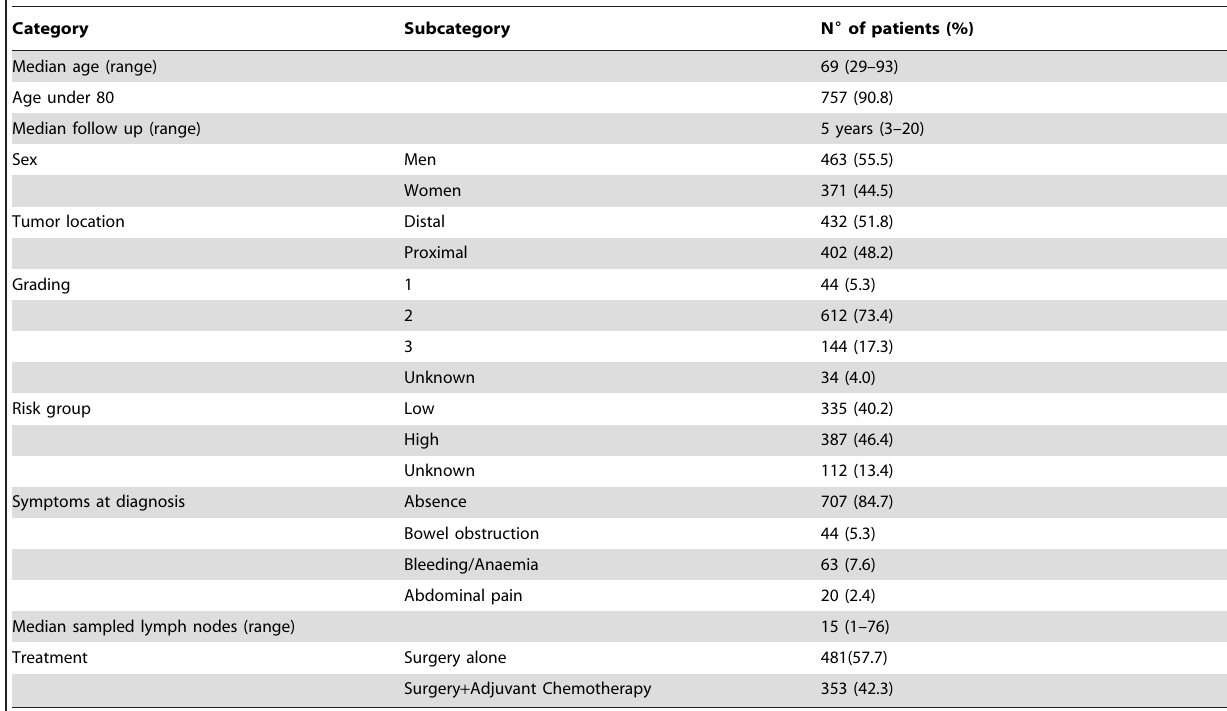
Table 1. Patient Characteristics (N= 834).